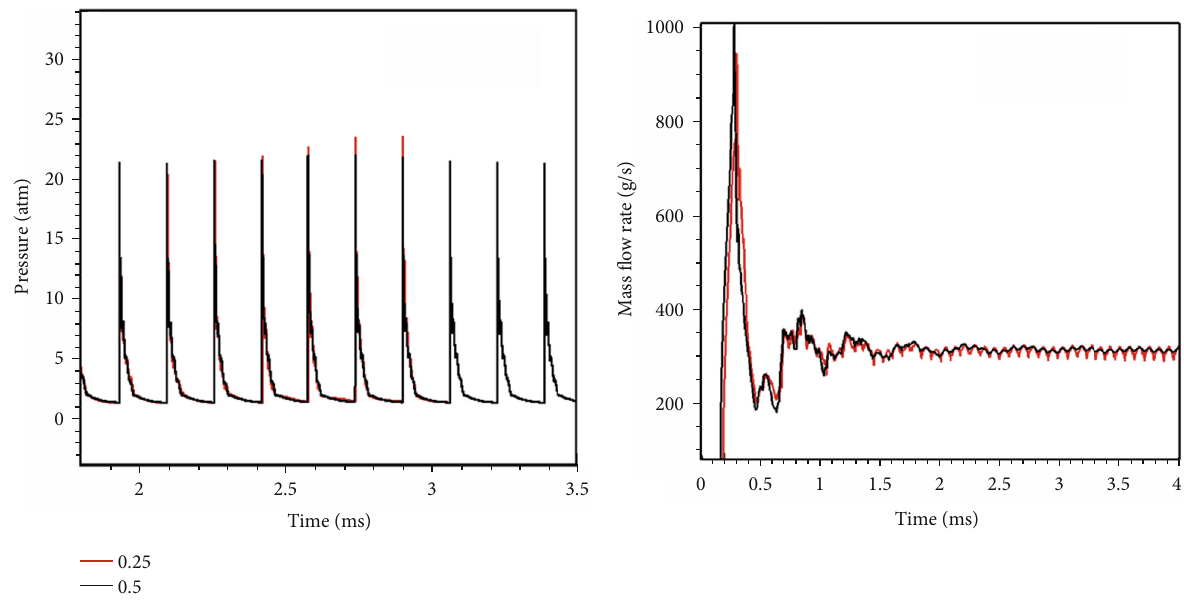
Figure 2: Pressure and outlet mass fl ow rate with two grid